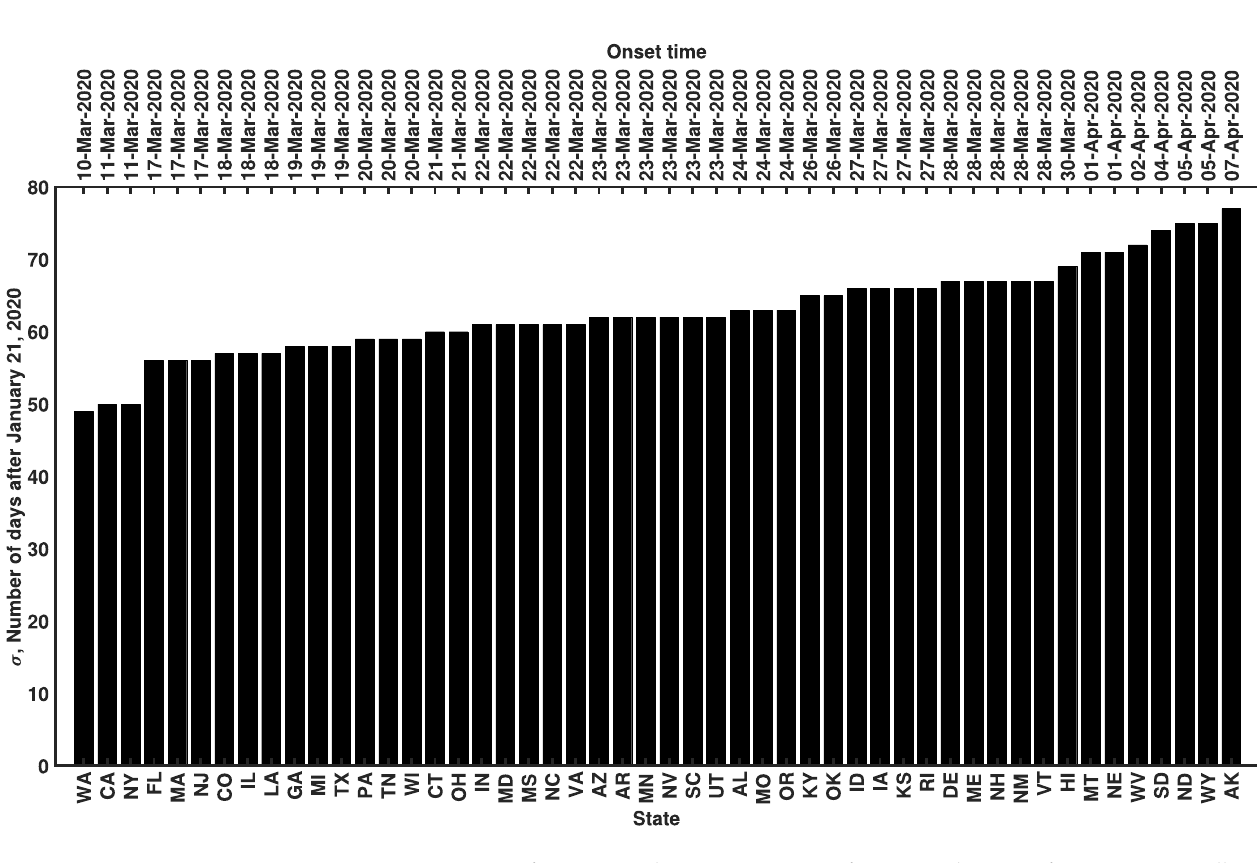
Figure 4. Onset times of COVID-19 disease transmission for ancestral strains of SARS-CoV-2 in all 50 US states. The onset time σ is defined as the first day on which the cumulative reported case count was 200 cases or more. Dates corresponding to σ values on the vertical axis are indicated above each bar. States are indicated using two-letter US postal service state abbreviations